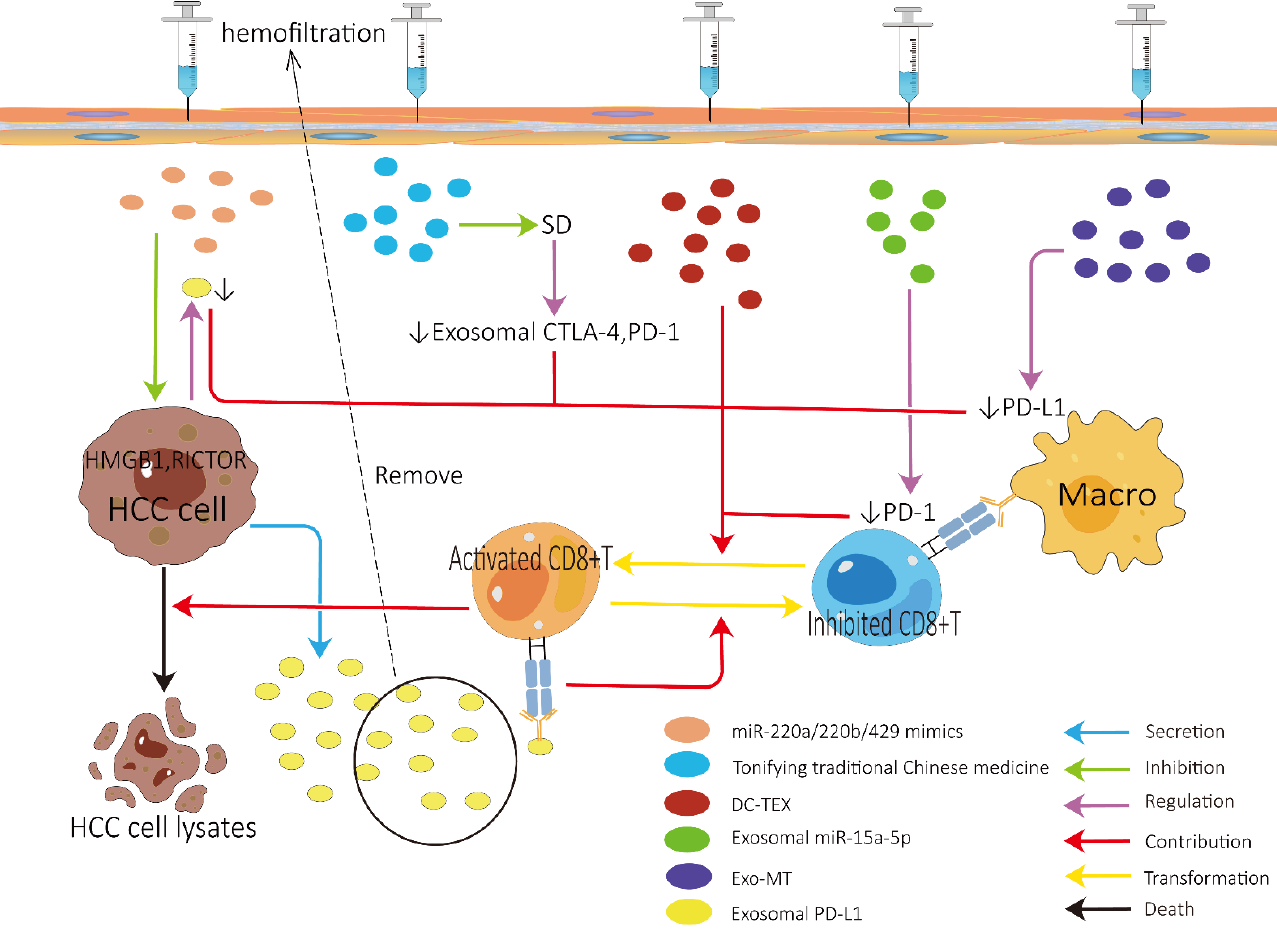
Figure 3. Potential role of exosomes in improving the efficacy of immune checkpoint inhibitors. HCC, hepatocellular carcinoma; Macro, macrophage; PD-L1, programmed cell death ligand 1; CTLA-4, cytotoxic-T-lymphocyte-associated protein 4; PD-1, programmed cell death protein 1; DC-TEX, tumor-cell-derived exosomes-pulsed DCs; SD, spleen deficiency; Exo-MT: Exosomes derived from HCC cells treated with 0.1 mM melatonin.